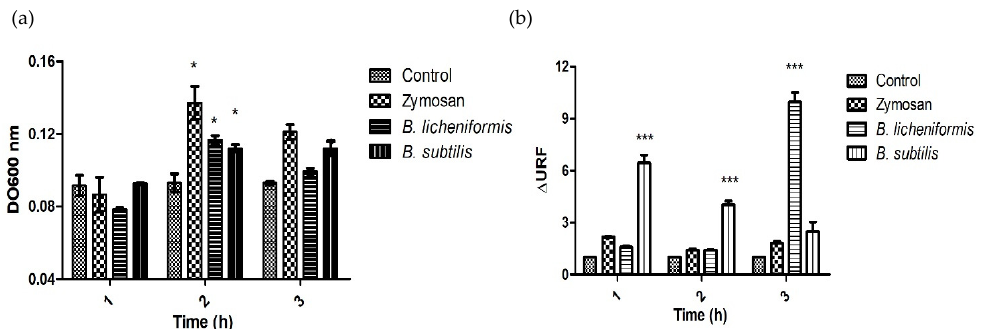
Figure 3. Macrophages infected with probiotics produce ROS and METs. ( a ) ROS production by macrophages infected with Bacillus species and treated with zymosan. ( b ) Quantification of DNA released by macrophages infected with Bacillus species and treated with zymosan determined by SYTOX fluorometry. Representative results of three experiments. ANOVA test for repeated measures was performed, followed by a post hoc t -test with a Bonferroni correction. * p < 0.05, *** p < 0.001.